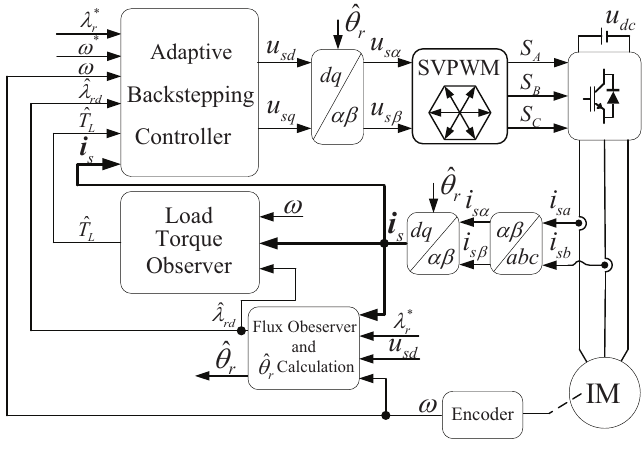
Figure 1. Block diagram of induction motor (IM) drive